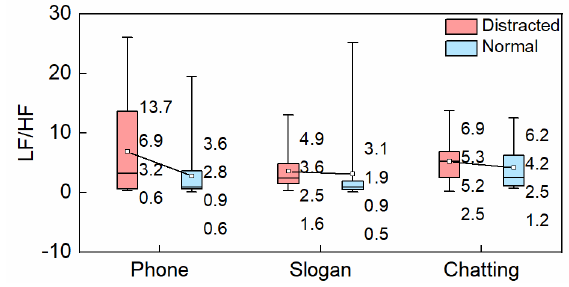
Figure 7. LF/HF. Figure 7.